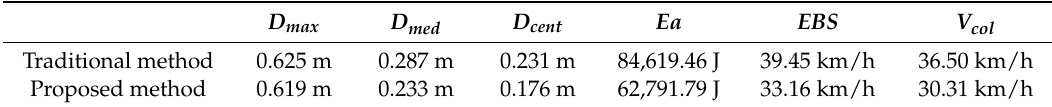
Table 6. Results obtained from energetic analysis.